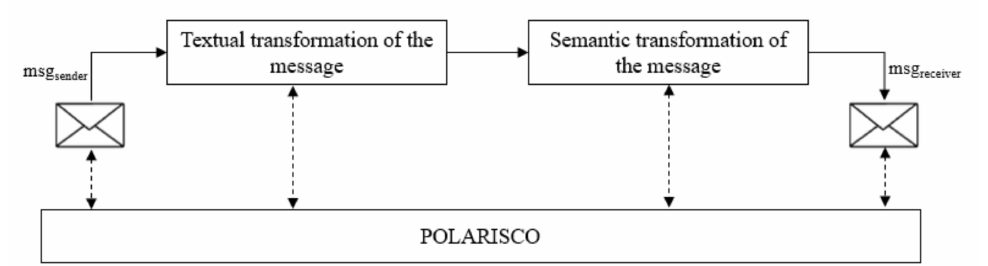
Figure 24. Message transformation process.